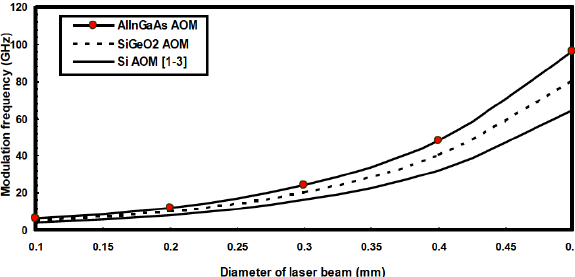
Figure 5: Variations in modulator speed response in relation to laser beam diameter for the previous and proposed AOMs at room temperature